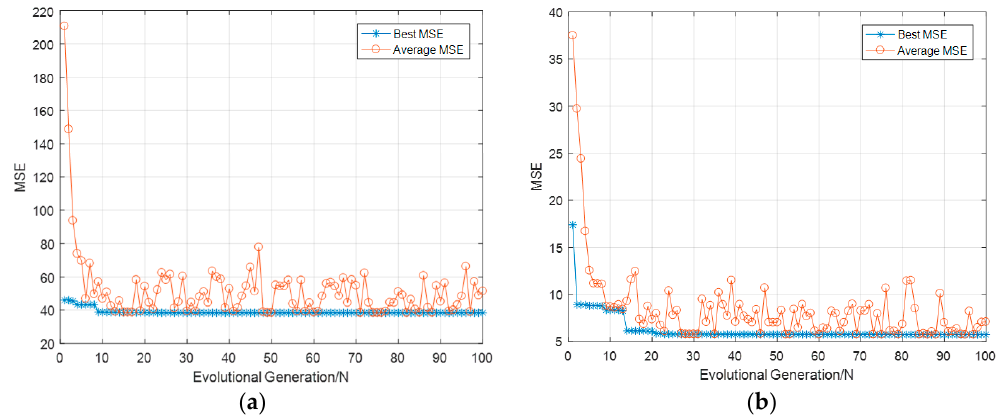
Figure 6. Genetic algorithm (GA) optimization process for initial models, the mean squared error (MSE) served as the fitness value of individuals in each generation. ( a ) Systolic blood pressure (SBP) model. ( b ) Diastolic blood pressure (DBP) model.